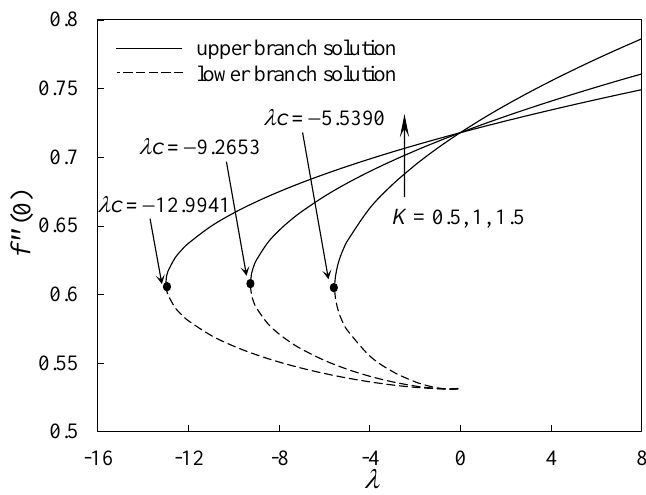
  0 f    0 f  with  for several values of K for Cu-water nanofluid. with  for several values of K for Cu-water nanofluid.